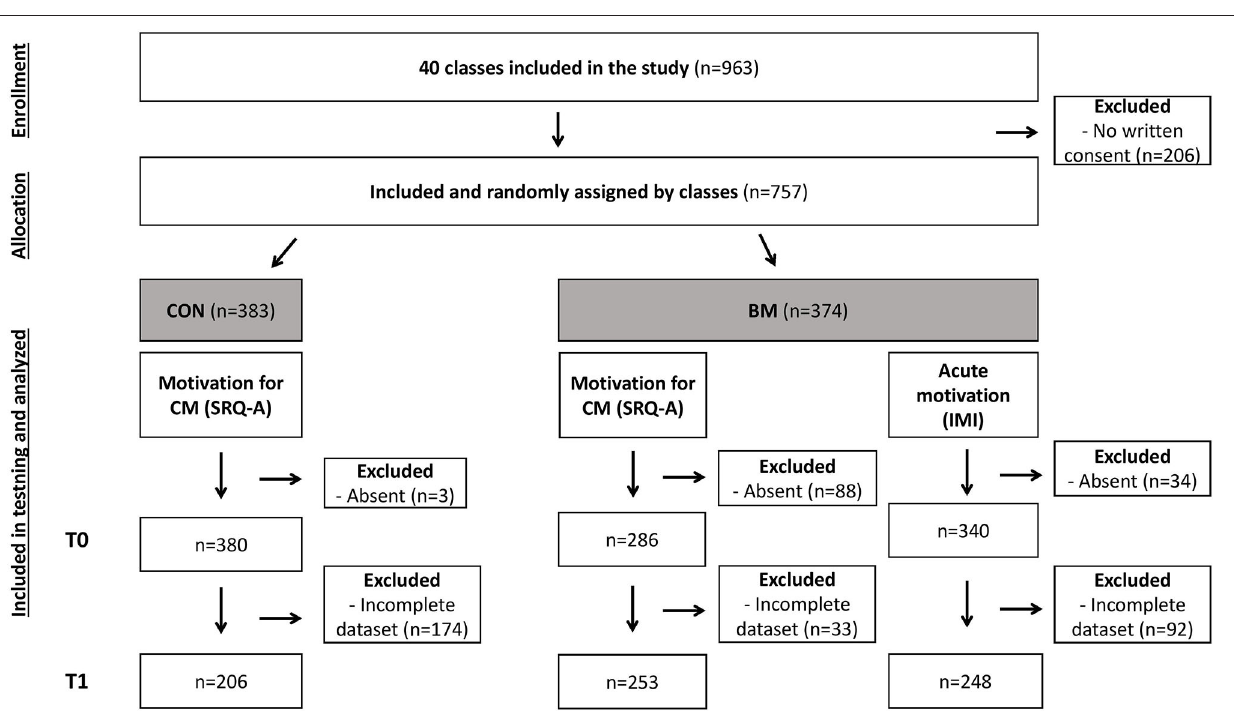
Frontiers in Psychology |